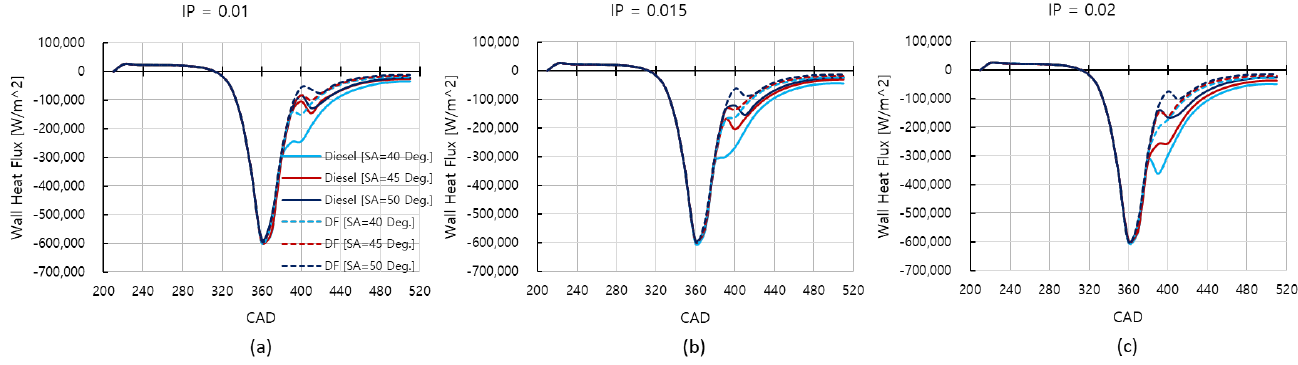
Figure 17. Wall heat fluxes in all simulation cases: ( a ) IP = 0.01 m; ( b ) IP = 0.015 m; ( c ) IP = 0.02 m.